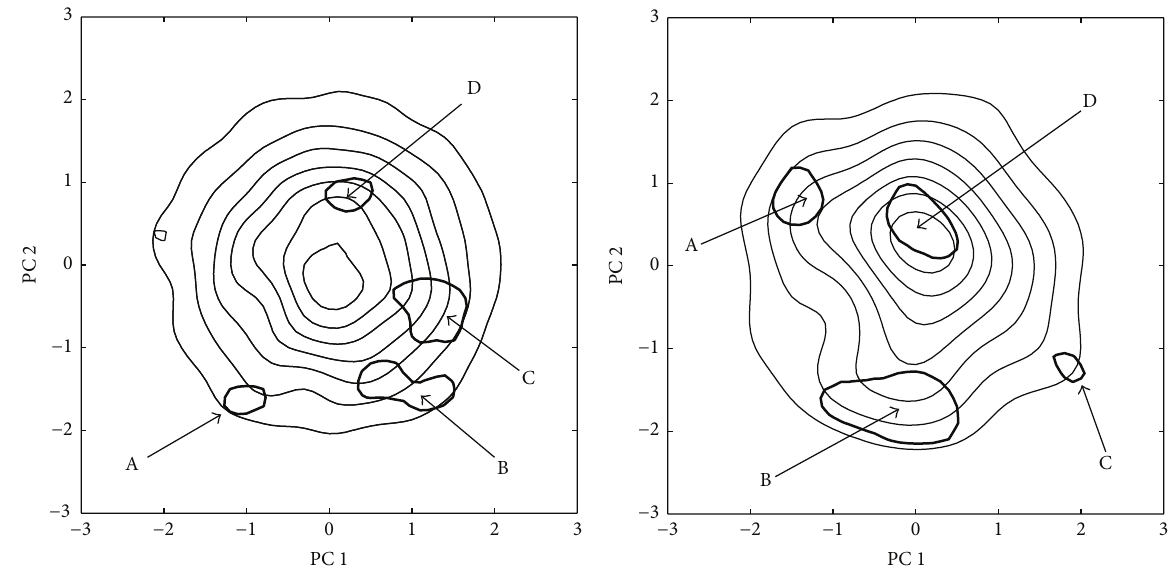
Figure 10: (Left) estimated probability density in the space spanned by the first two PCs of the 833 hPa geopotential height field. Contour interval is 0.02; zero contour omitted. The thick lines enclose areas with significantly higher probability than what to be expected in the case of adapted red noise process (at the 95% significance level) and thus mark the circulation regimes. The regimes are denoted as indicated in the text. (Right) as left column, but for the layer-averaged NCEP-NCAR reanalysis data with significance at the 85%